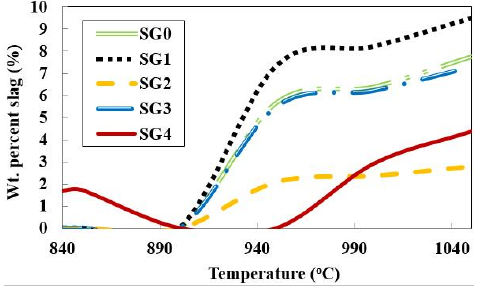
Figure 2. Slag ‐ liquid formation tendencies of whole coal and density fractions of Pittsburgh No. 8 seam coal. Table 3. Temperature of slag ‐ liquid formation onset for each gravity fraction and whole coal (FactSage ™ predictions).